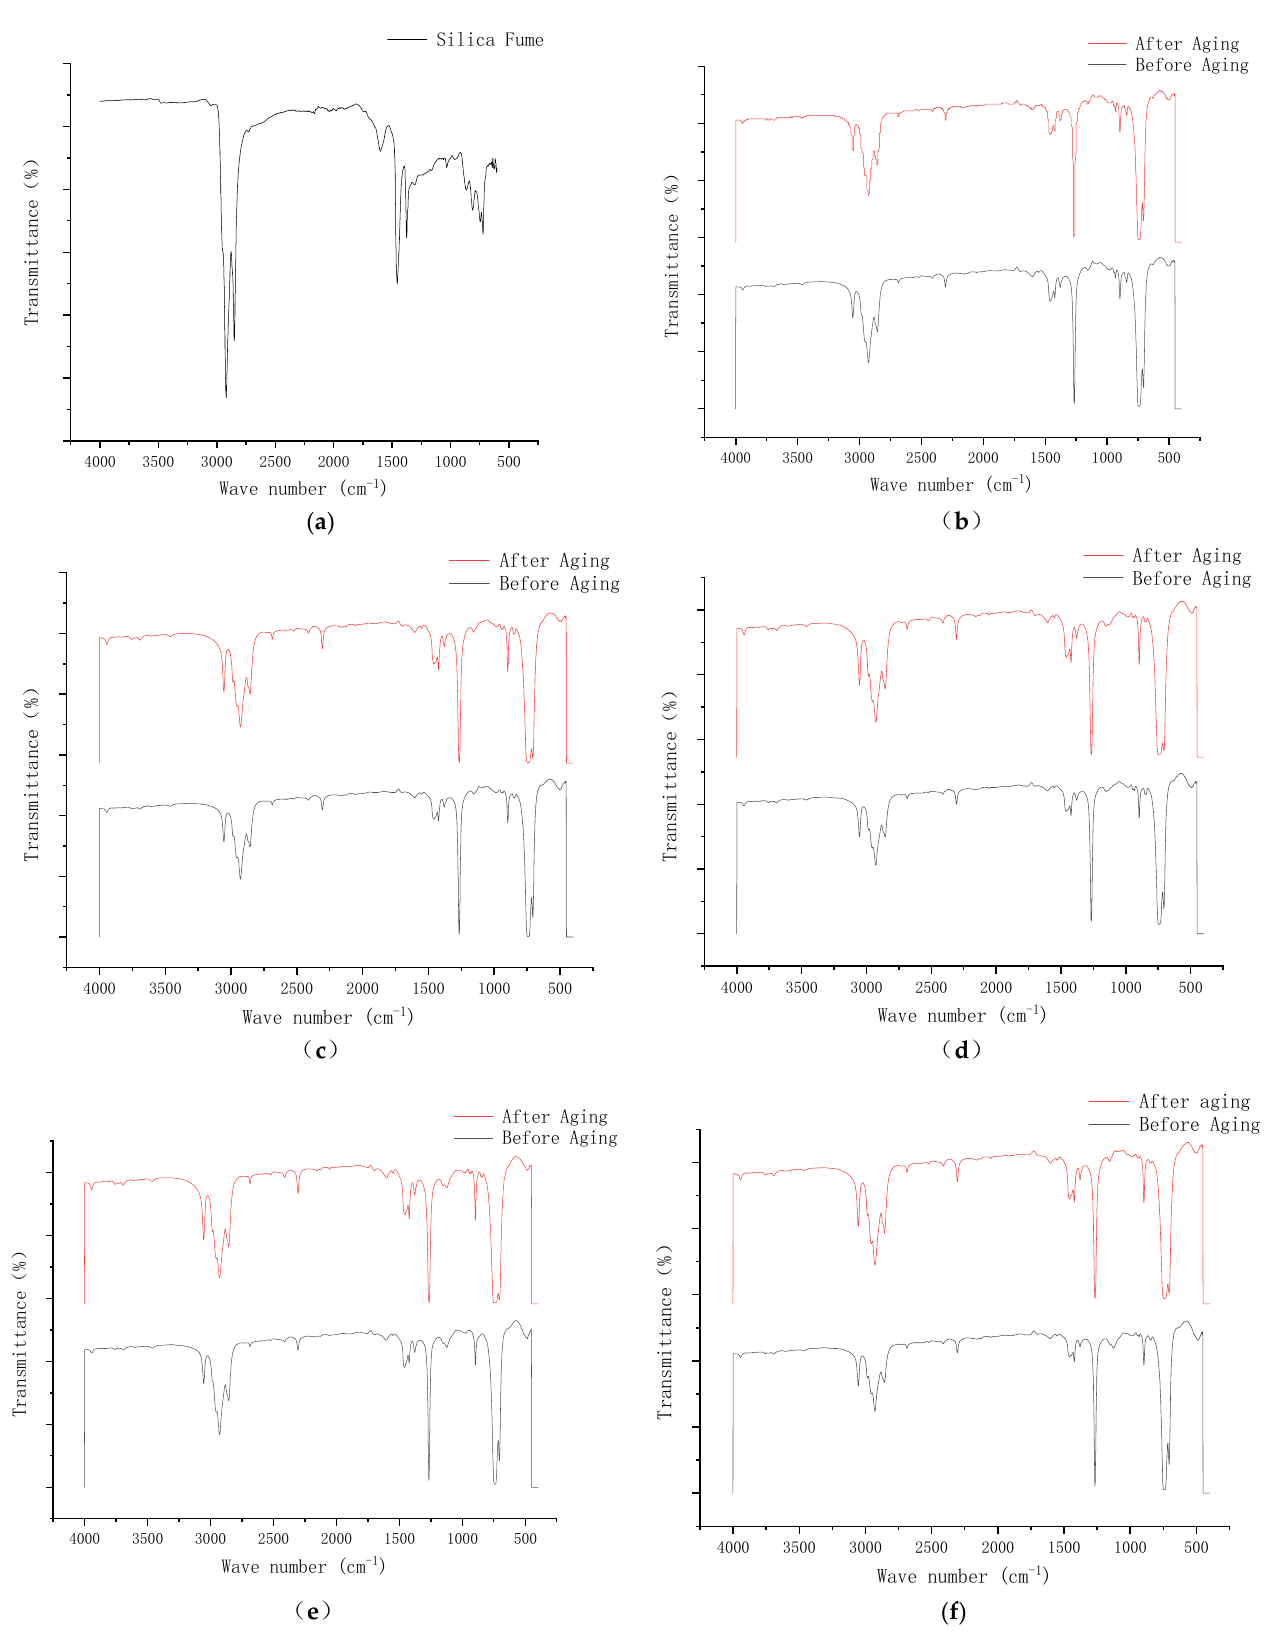
Figure 4. Fourier transform infrared spectra of ( a ) silica fume; ( b ) 4%SBS modified asphalt; ( c ) 4%SBS + 2%silica fume composite-modified asphalt; ( d ) 4% SBS + 4% silica fume composite-modified asphalt; ( e ) 4% SBS+6% silica fume composite-modified asphalt; and ( f ) 4% SBS+8% silica fume composite-modified asphalt.